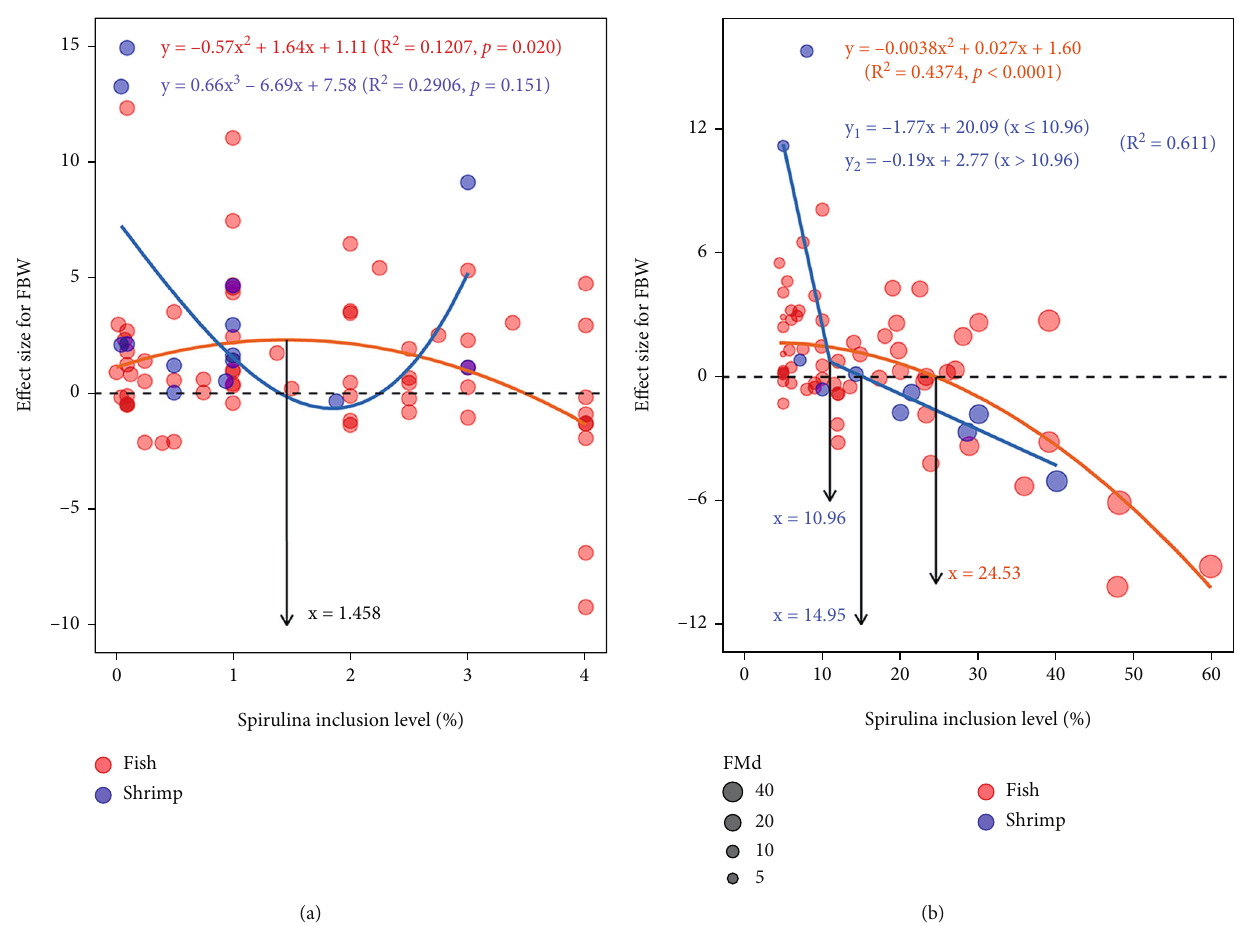
Figure 3: Random-e ff ects model regression of spirulina meal inclusion level as a feed additive (a) and feed ingredient (b) on the e ff ect size of FBW. The circle size represents the replaced level (%) of fi shmeal by SPM, in other words, it means the di ff erence of fi shmeal content between the control group and SPM supplemented